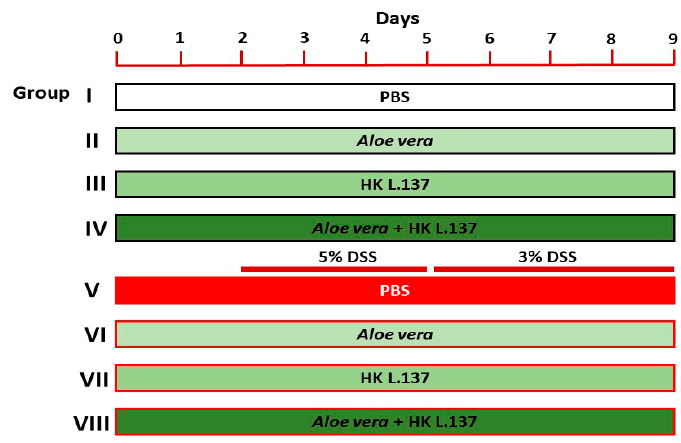
Figure 1. A schematic diagram showing the experimental groups and treatments.